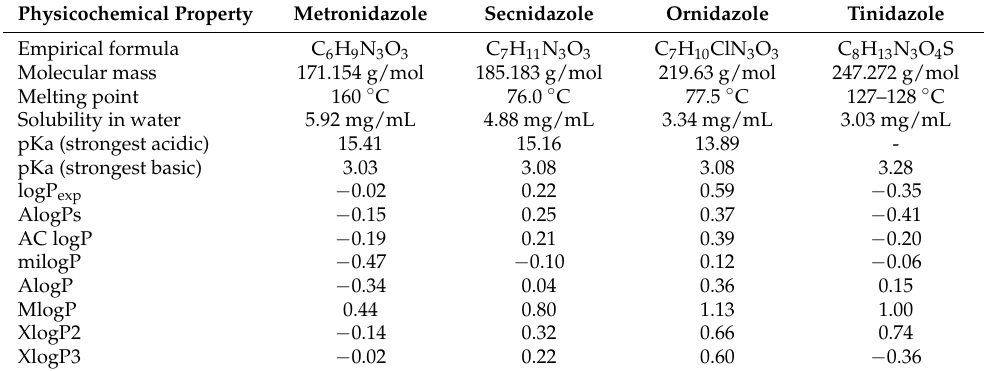
Figure 1. Structural formulas of metronidazole, secnidazole, ornidazole, and tinidazole. Table 1. Selected physicochemical properties of metronidazole, secnidazole, ornidazole, and tinidazole [2–7].